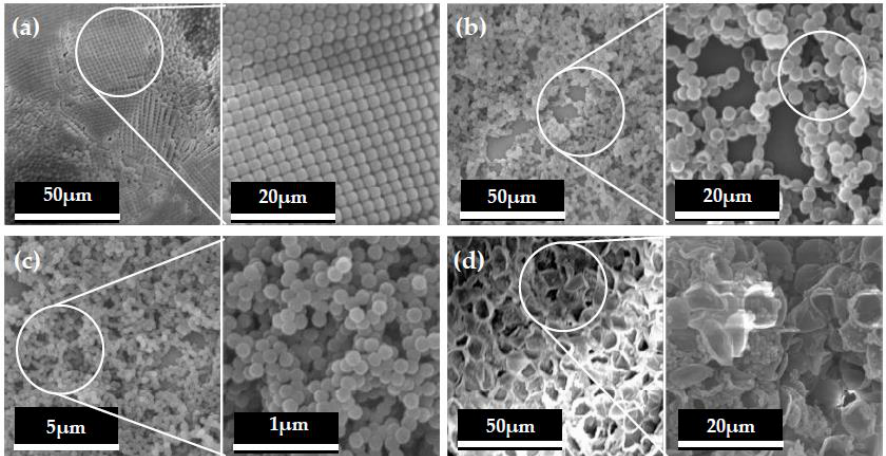
Figure 2. SEM morphology photos of micro-spherical appearance. ( a ) Polystyrene; ( b ) micron hollow mesoporous microspheres; ( c ) nano hollow mesoporous microspheres; ( d ) nano/Micro hollow mesoporous microspheres.